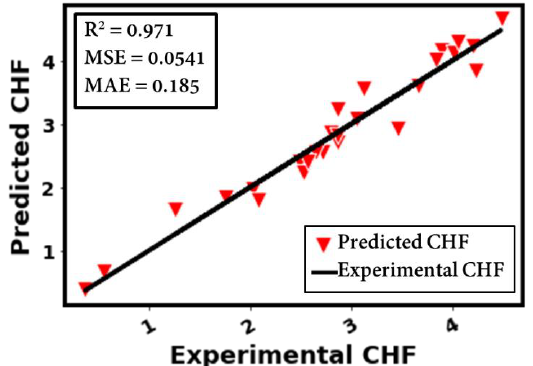
Figure 12. Prediction plot to assess the actual and anticipated data of the CHF.